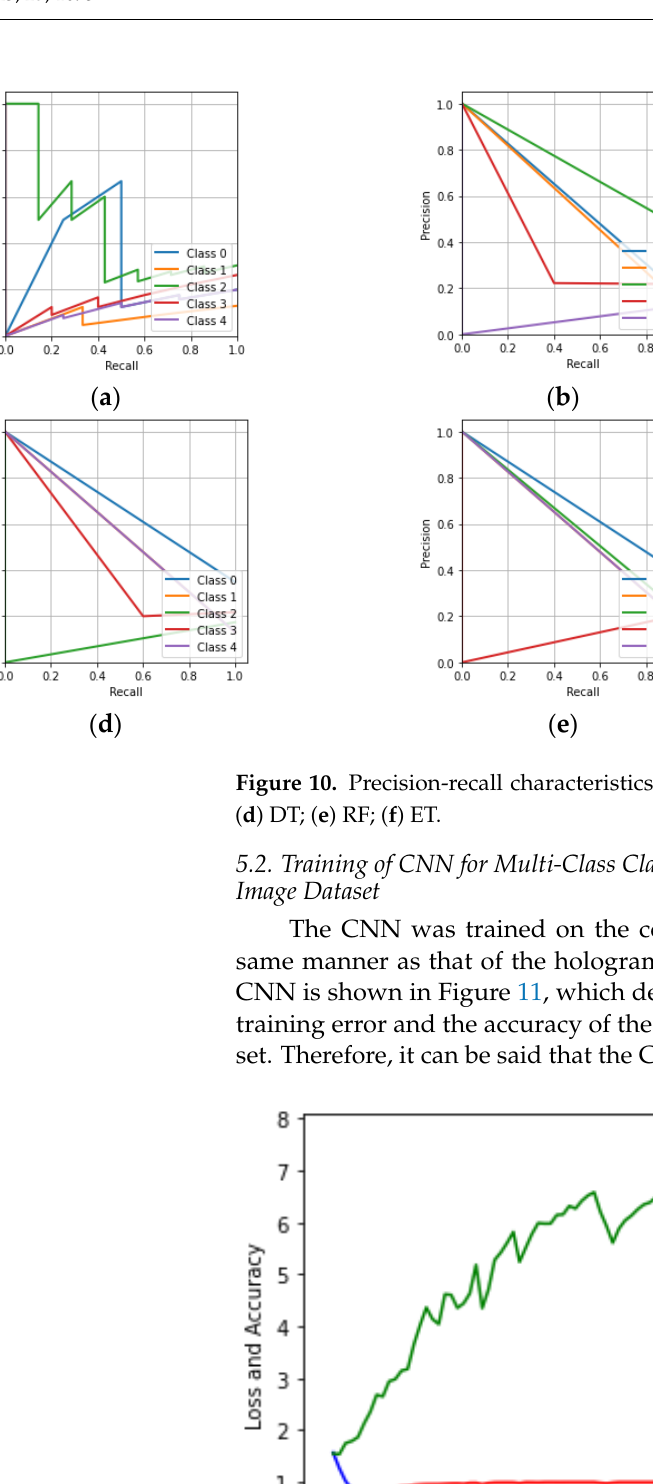
Figure 11. Loss and accuracy plot for the concatenated intensity – phase (IP) image dataset.